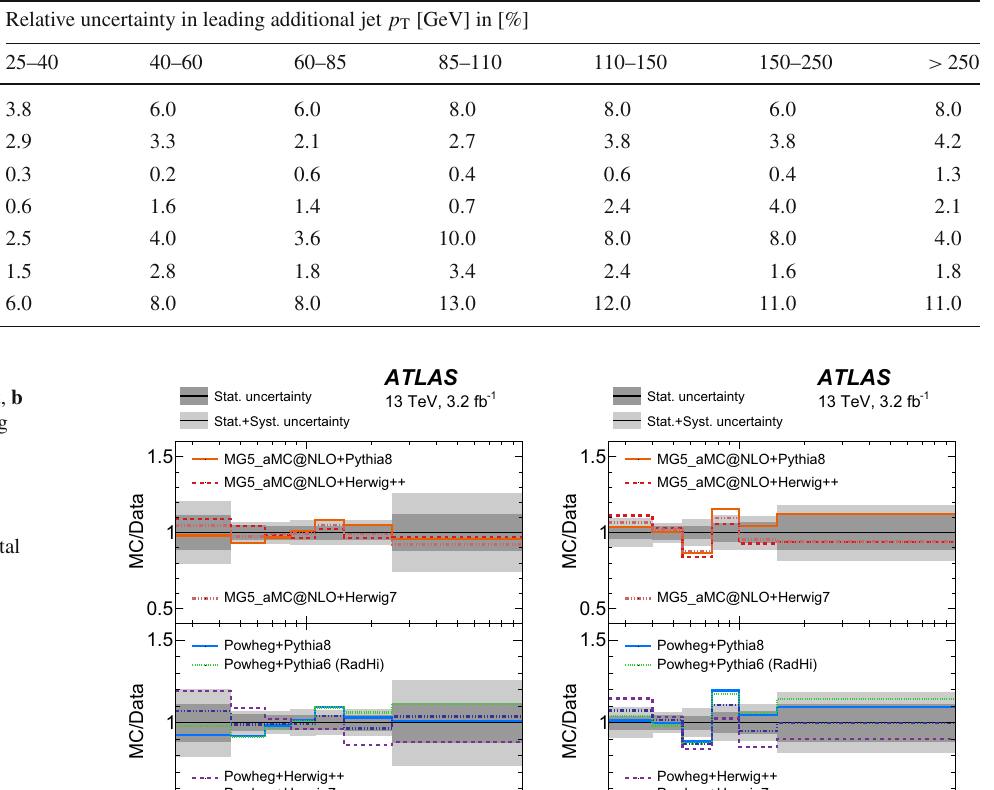
NLO modelling uncertainties. “Other” sources of systematic uncer- tainty refers to lepton and jet selection efficiencies, background (includ- ing pile-up jets) estimations, and the PDF